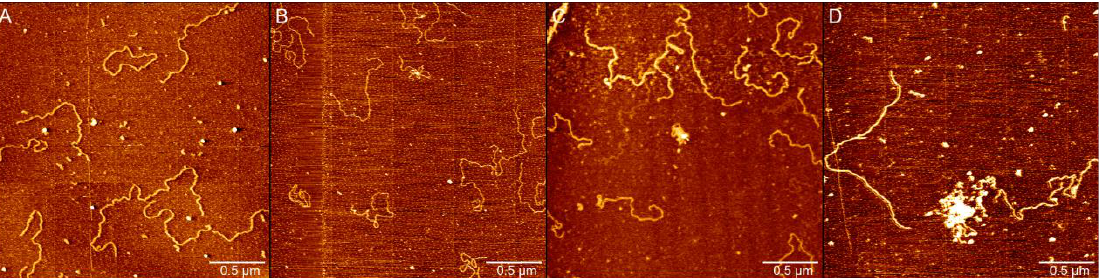
Figure 5. AFM images of 4000 bp linear DNA in deposition buffer (1 mM MgCl 2 , 10 mM HEPES (pH 7.5)) which contain 500 mM ectoine at different concentrations of PN. ( A )300 µM, ( B ) 400 µM, ( C ) 500 µM, ( D ) 1 mM.